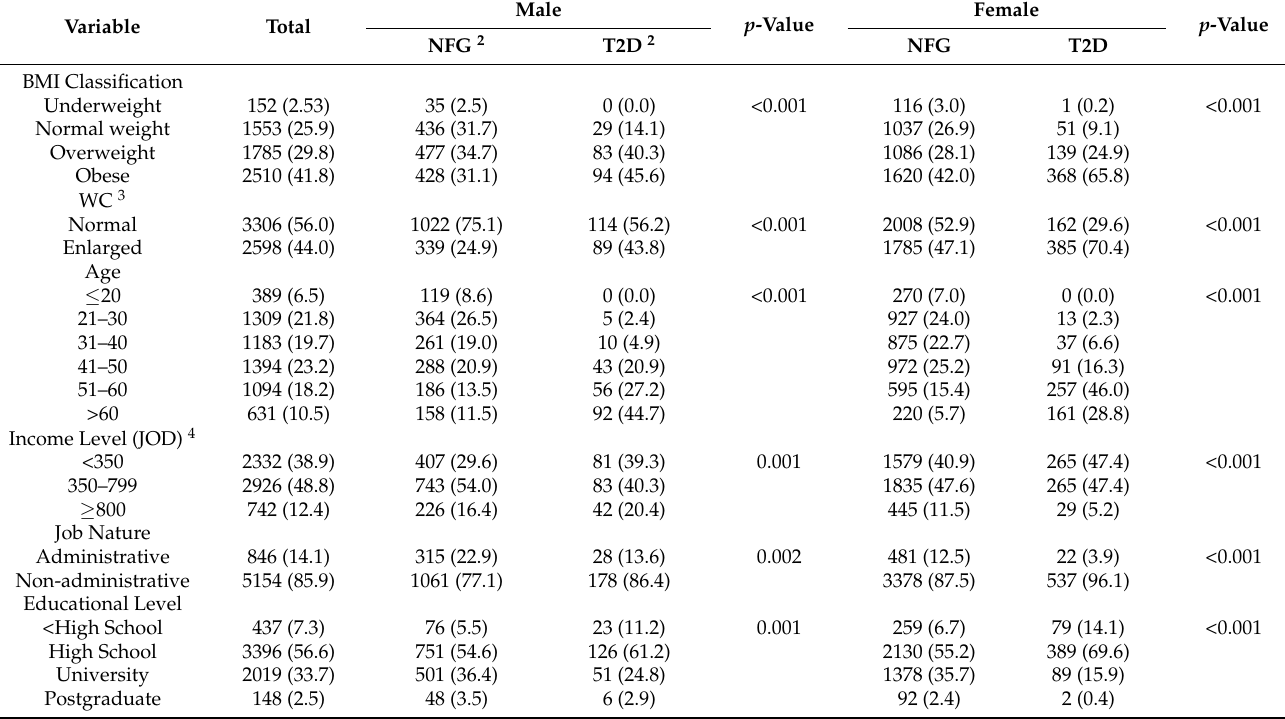
Table 3. Type 2 Diabetes (T2D) relation with BMI, WC, and population characteristics stratified by sex 1